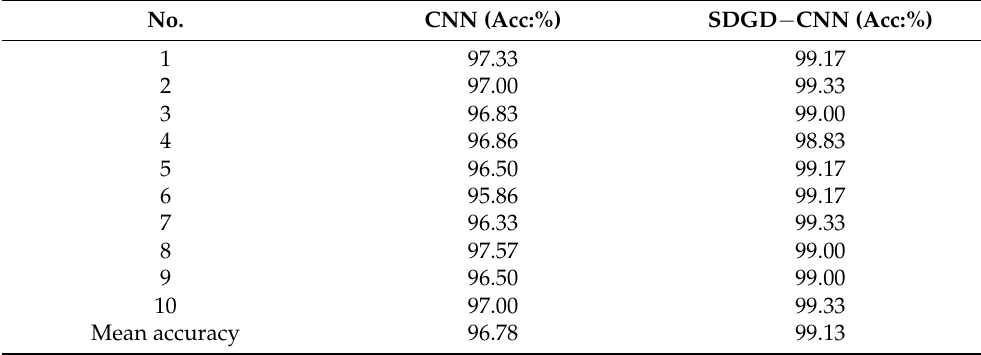
Table 7. Accuracy comparison.